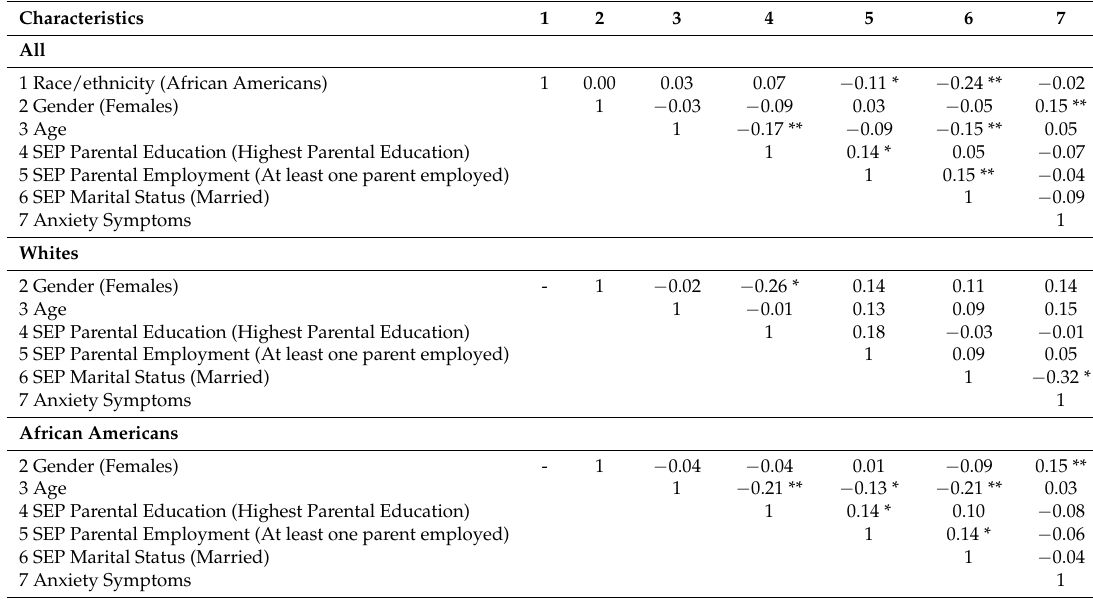
Table 2. Correlations in the pooled sample and by race/ethnicity.